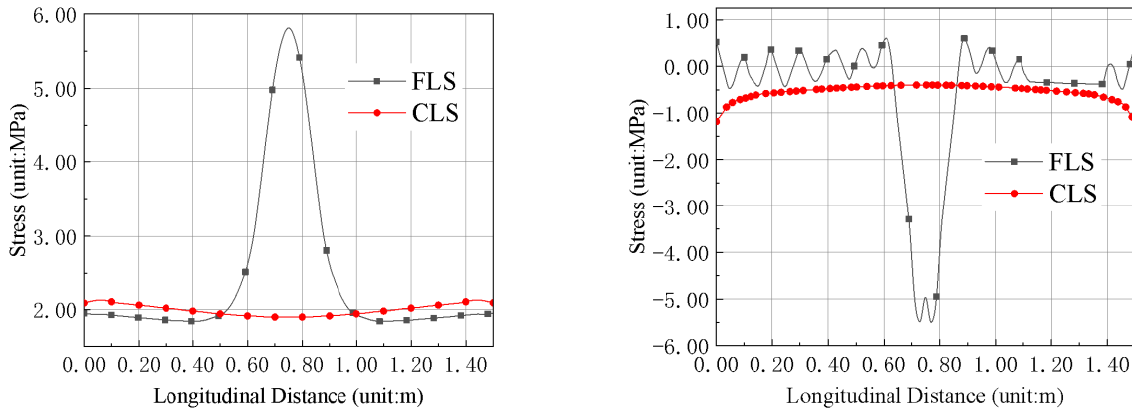
Figure 11. Stress distribution on link-slab under global warming.